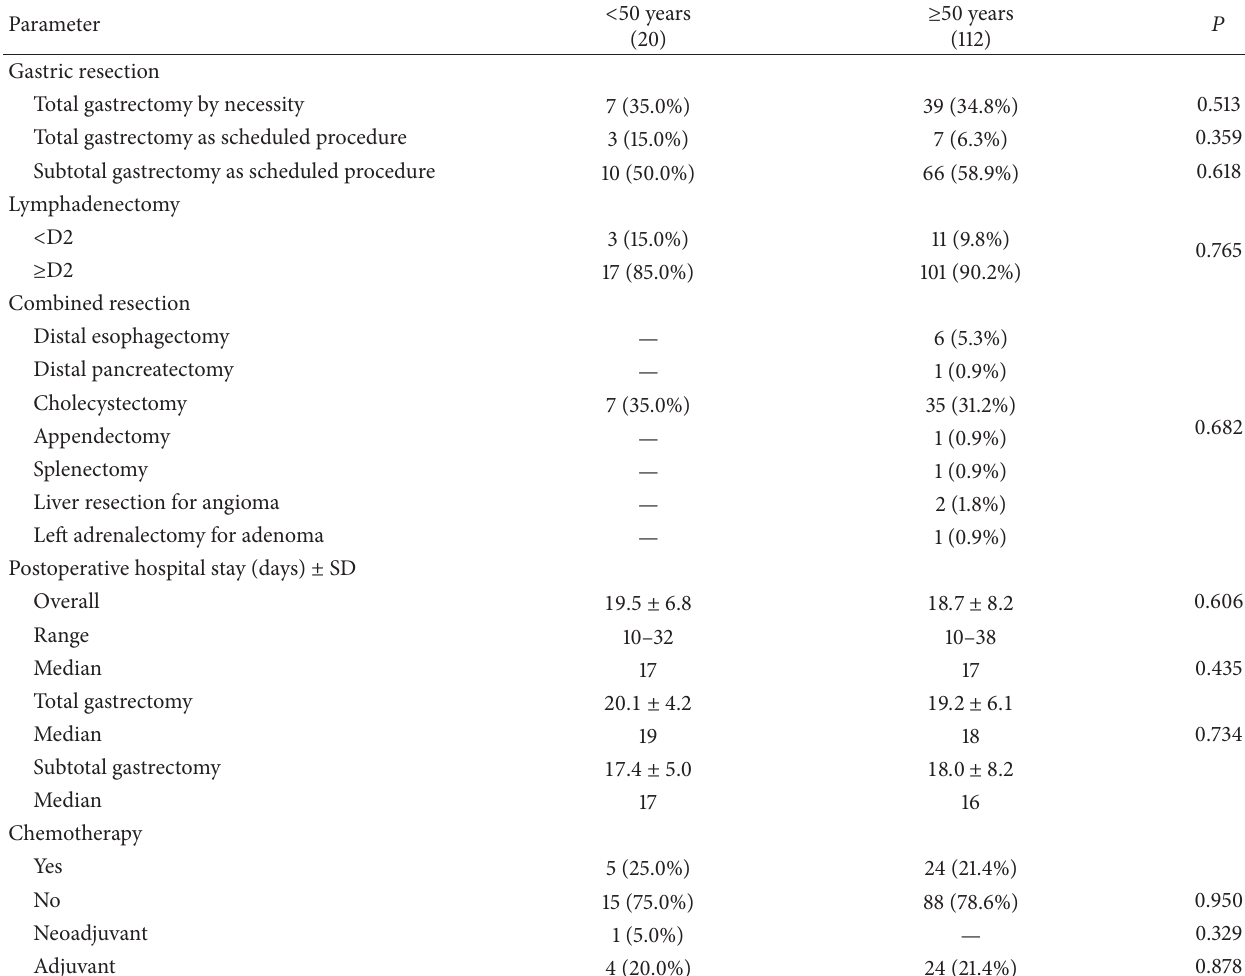
Table 3: Surgical treatment, length of postoperative hospital stay, and